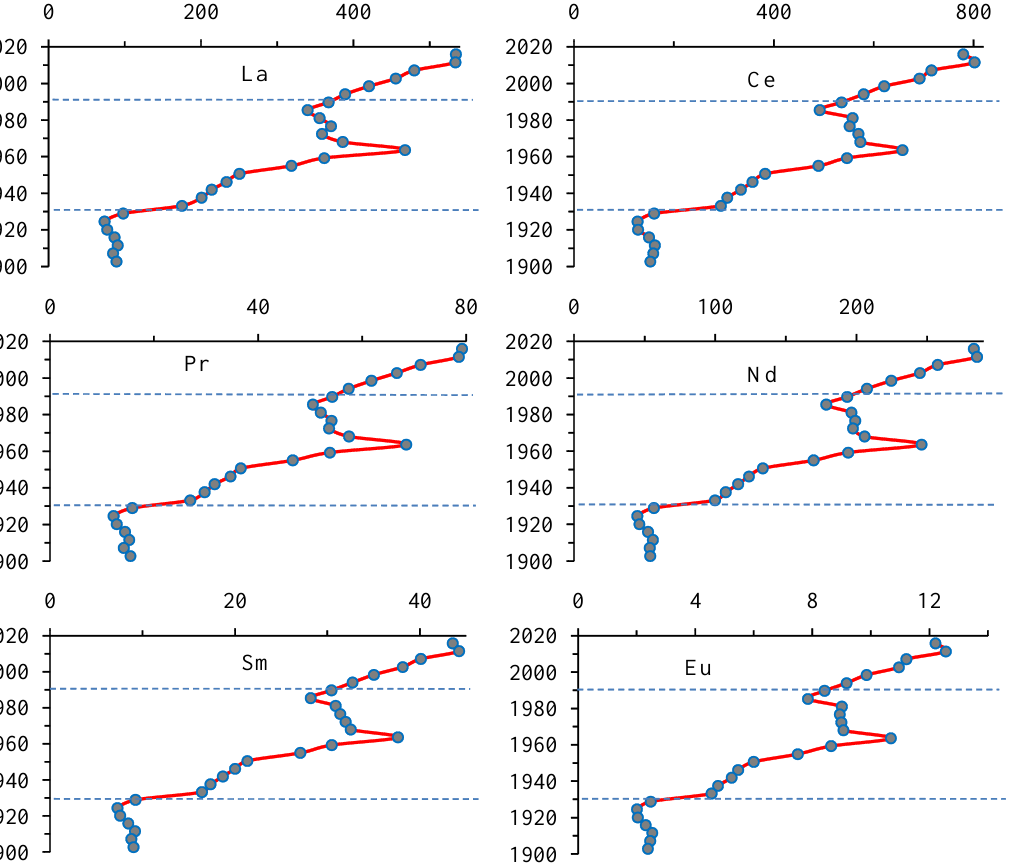
Figure 7. Vertical distribution of the content (µg/g) of light rare earth elements in the sediments of Lake Bolshoy Vudjavr.